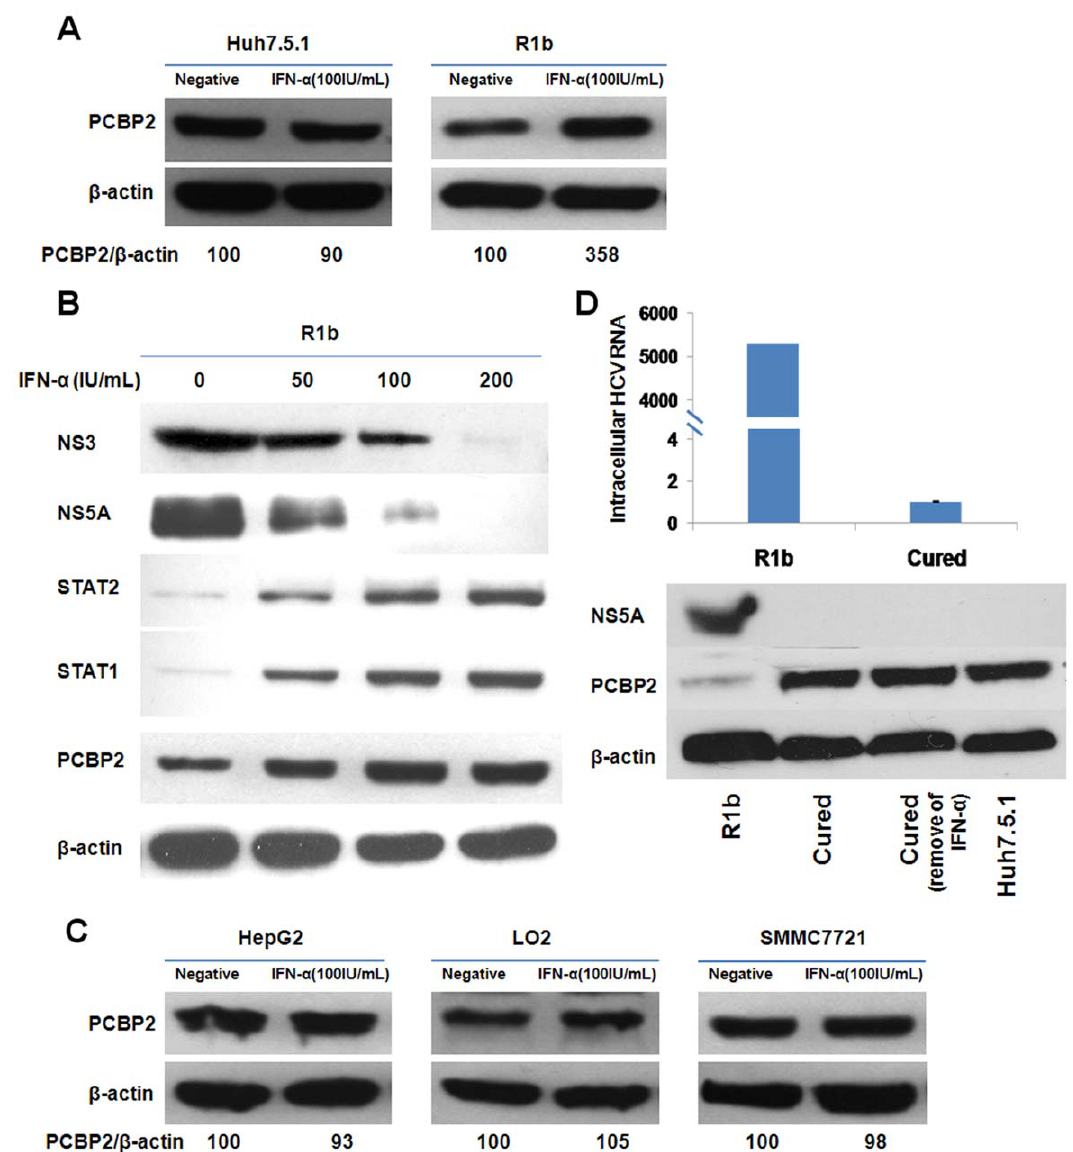
Figure 2. IFN- a restores the expression level of PCBP2 in R1b cells after inhibiting the expression of HCV replicon. (A) Western blotting analysis indicated prominent up-regulation of PCBP2 in R1b cells after treated with 100 IU/mL IFN- a , while no significant differences were noted in Huh7.5.1 cells. (B) The restoration of the expression of PCBP2 is IFN- a dosage dependent and due to inhibition of HCV NS proteins. IFN- a doses of 50, 100 and 200 IU/mL were used to treat R1b cells for 6 hours. Western blotting was performed to detect the expression of proteins. (C) PCBP2 protein level in other hepatocyte-derived cells after treatment of 100 IU/mL IFN- a . The PCBP2 level was unchanged, similar to that observed in Huh7.5.1 cells. (D) The protein level of PCBP2 was restored in cured R1b cells. The PCBP2 level did not return to a low level when IFN- a was removed from the media for a week.